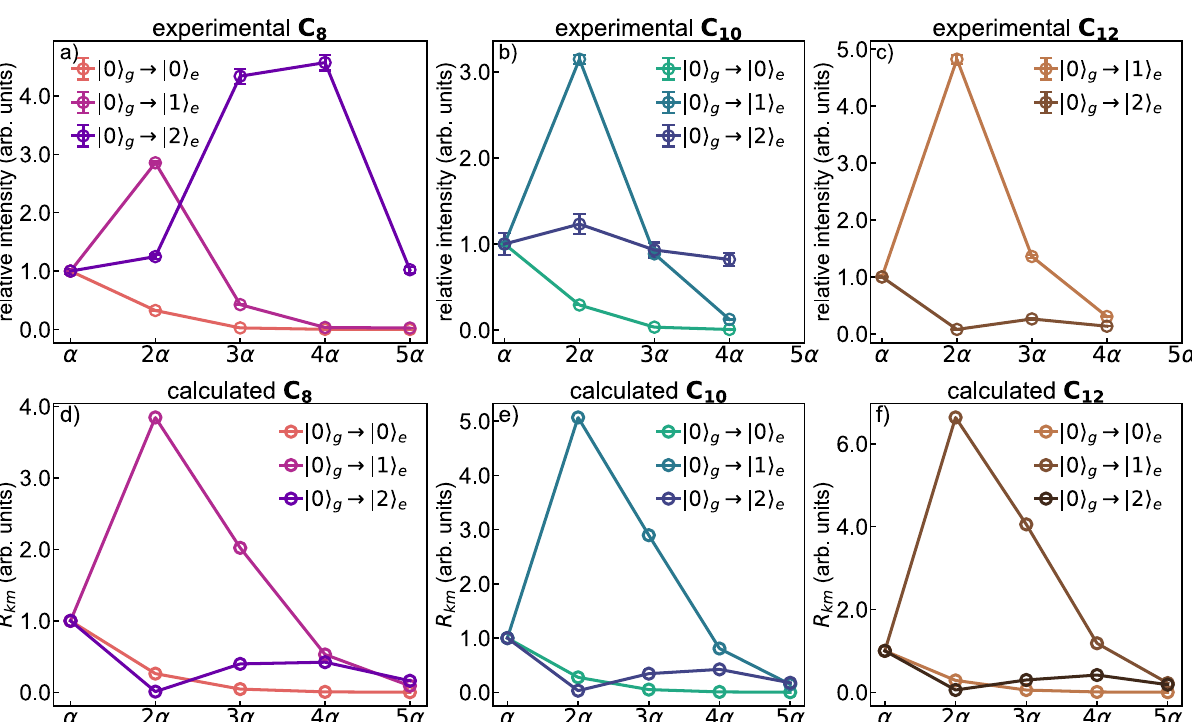
Fig. 5 | Experimental andcalculatedrelative intensitiesof the overtones ofthe (273nm, ∣ 0 i g ! ∣ 0 i e )couldnotberecordedduetolimitationsintheundulatorgap α modeofC α modeofC aperture. The errorbars of panels a – c represents the error of the fi t model used to 8 ,C 10 ,andC 12 . Relativeintensitiesoftheovertonesofthe 8 ( a ), C 10 ( b ), C 12 ( c ) determined as peak intensities compared to that of the fi rst- deconvolvetheUVRRspectra.Panelsfrom d – f displaythepredictionoftherelative order α mode of the experimental resonance Raman spectra excited at different intensityofthe m -thovertoneoftheRaman α line of C 8 ( a ),C 10 ( b ),and C 12 ( c )asa wavelengths, corresponding with the resonance conditions listed in Supplemen- function of the resonance condition, as computed according to Eq. tary Table 1. The spectrum corresponding to the absorption maximum of C 12